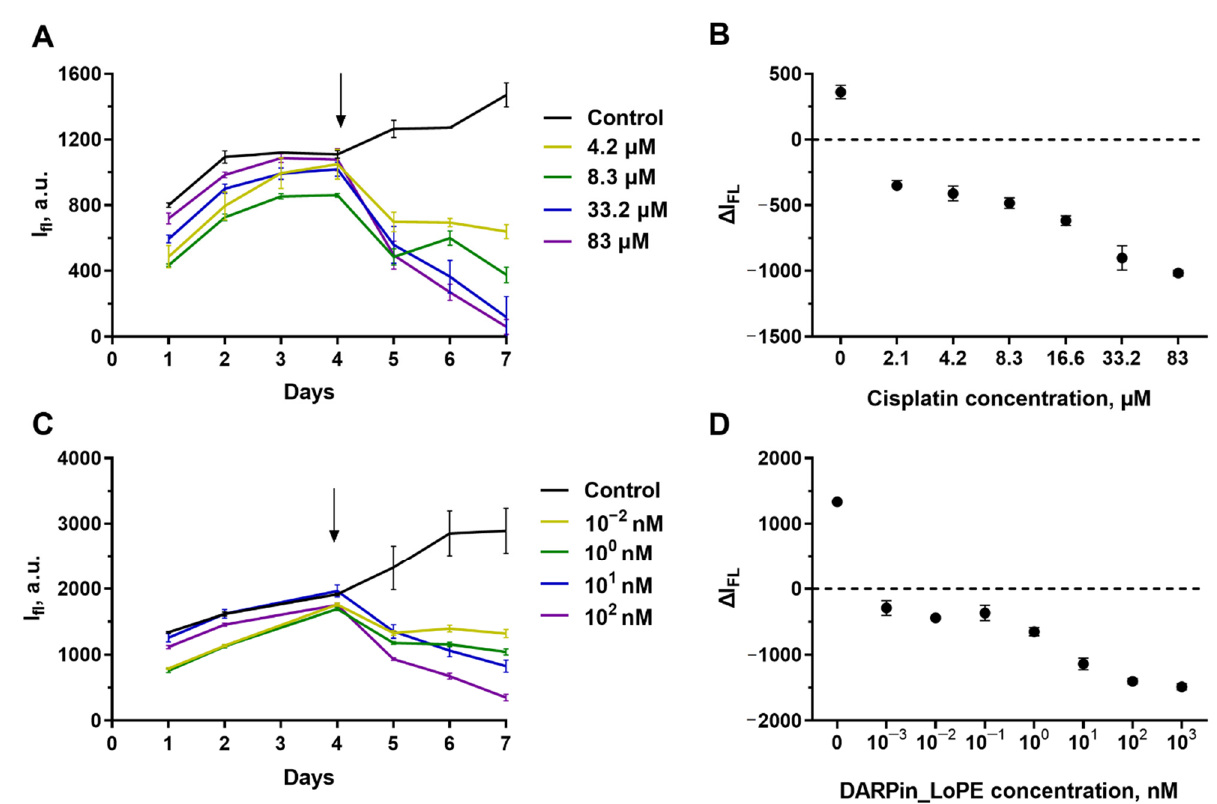
Figure 4. Cytotoxicity of cisplatin ( A , B ) and targeted toxin DARPin-LoPE ( C , D ) against SKOV3.ip-kat cells embedded in collagen hydrogel. ( A , C ) Dynamics of changes in the fluorescence signal from hydrogels treated with different concentrations of antitumor agents. On day ‘zero’, 6 × 10 5 cells were embedded in the gel. The day cisplatin or DARPin-LoPE was added to the medium is indicated by an arrow. ( B , D ) ∆ I fl values 72 h after the start of hydrogels exposure to cisplatin ( B ) and DARPin-LoPE ( D ). The data are presented as mean ± standard deviation.